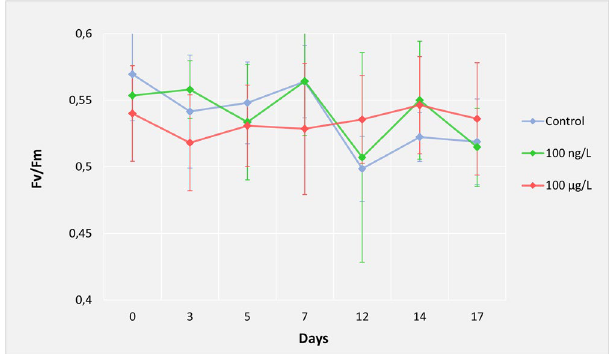
Figure 1. Measurements of F v / F m in Mussismilia harttii during the 17 days of experiment, with the treatments: control (without EE2), 100 ng L −1 and 100 µg L −1 of EE2 (n =